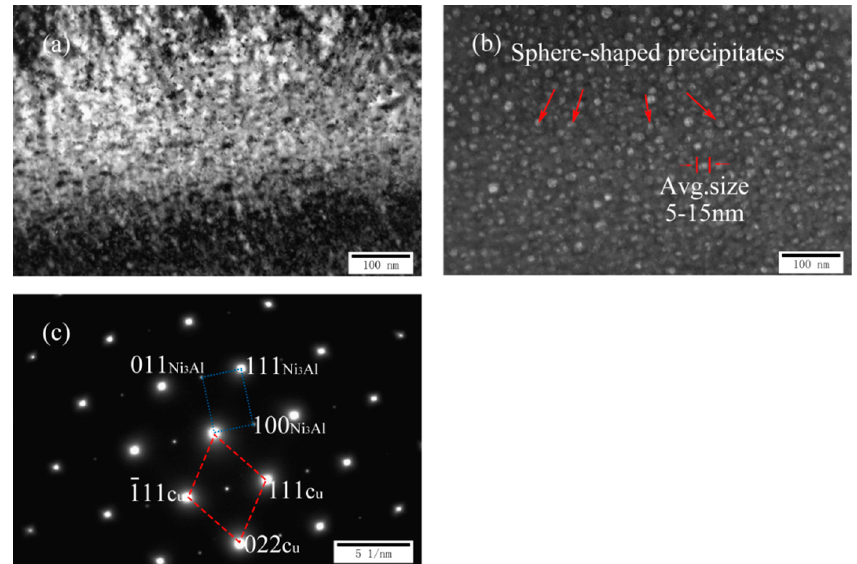
Figure 4. Microstructures of cast Cu-7Ni-3Al-1Fe-1Mn alloy: ( a ) bright-field image; ( b ) dark-field image; and ( c ) the corresponding SADP of ( a ).